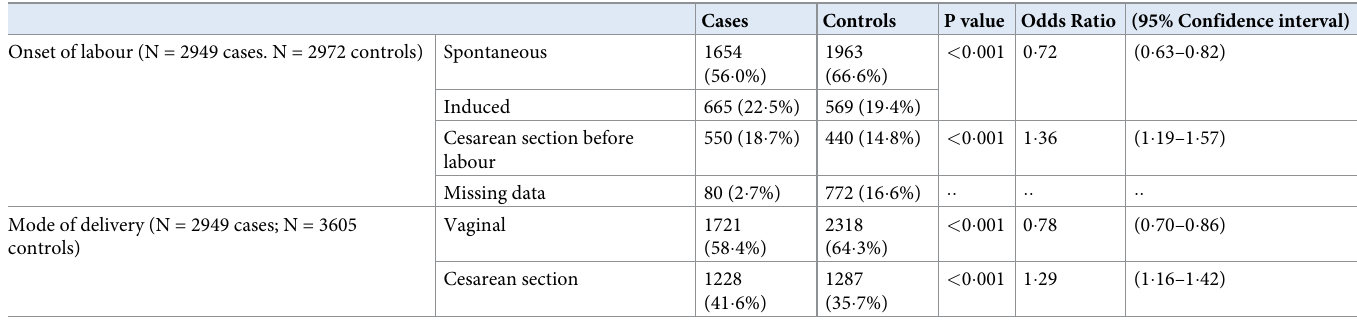
Table 7. Delivery outcomes in cases vs